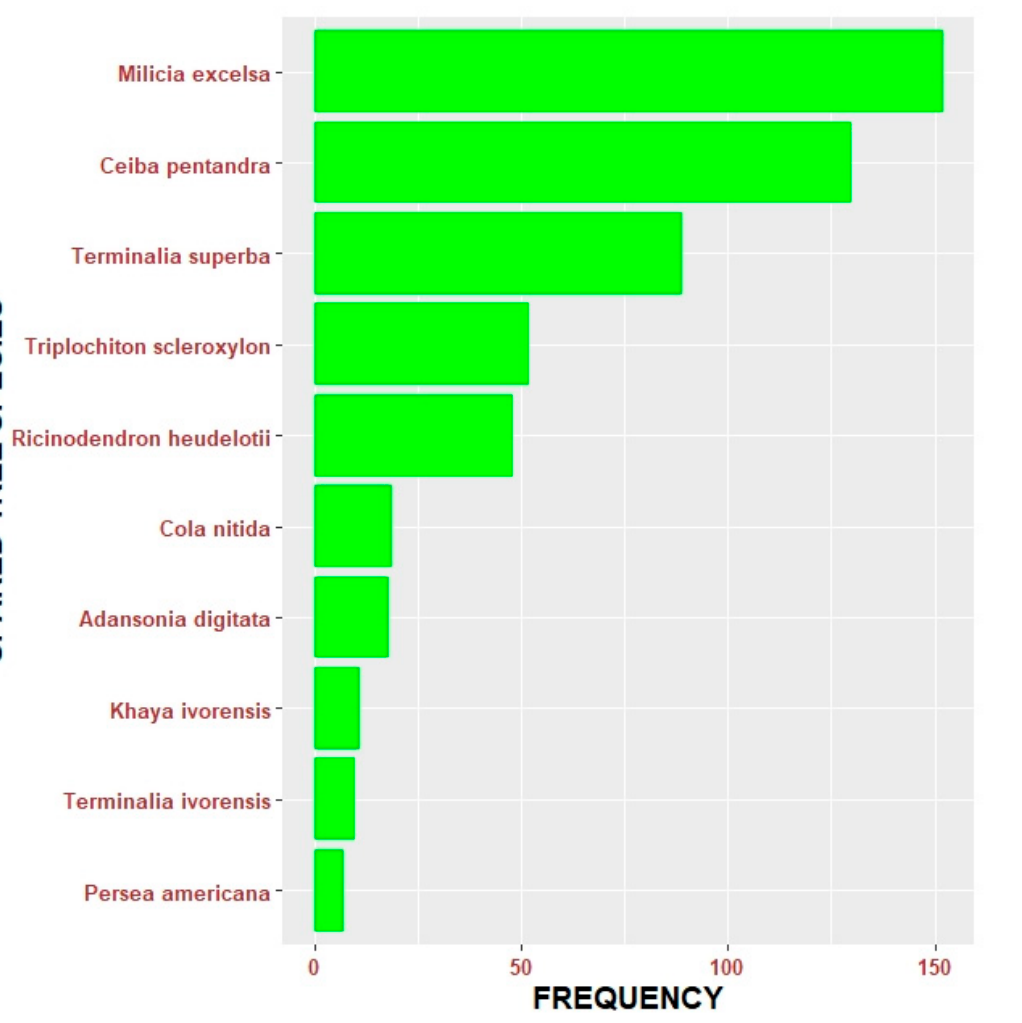
Figure 4. Tree species that are most frequently spared when clearing land for cocoa farming in Côte d’Ivoire. We found no significant difference between sites previously under different land-use systems, although 50% of surveyed households introduced more tree species in plots that had been previously used for food cropping (Table 4). Table 4. Influence of previous land-use systems on the number of tree species that are introduced to cocoa farms in the cocoa-producing zone of Côte d’Ivoire. Source of Variation Frequency